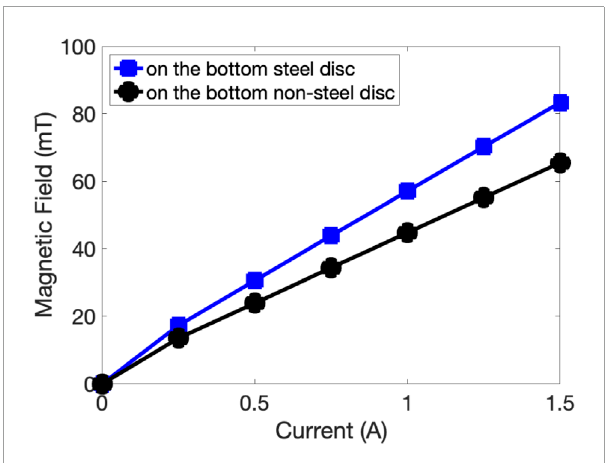
FIGURE 4 Measured magnetic field at the bobbin center of the 3D-printed MRVI.